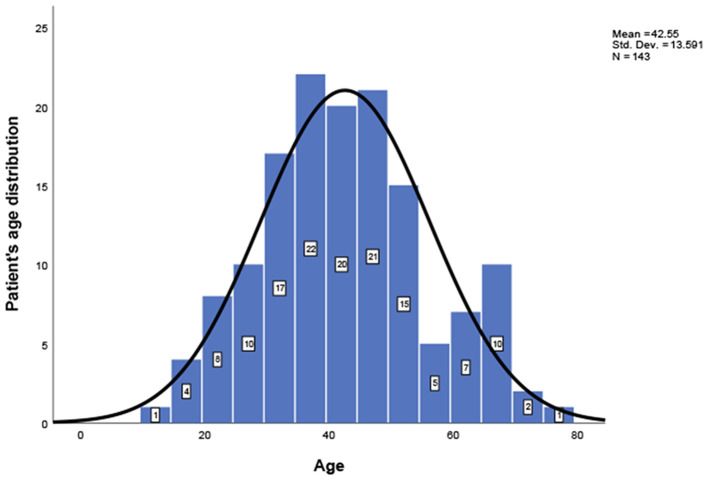
Patients' age distribution; a one-sample Kolmogorov-Smirnov test confirms that the age distribution follows a normal distribution.